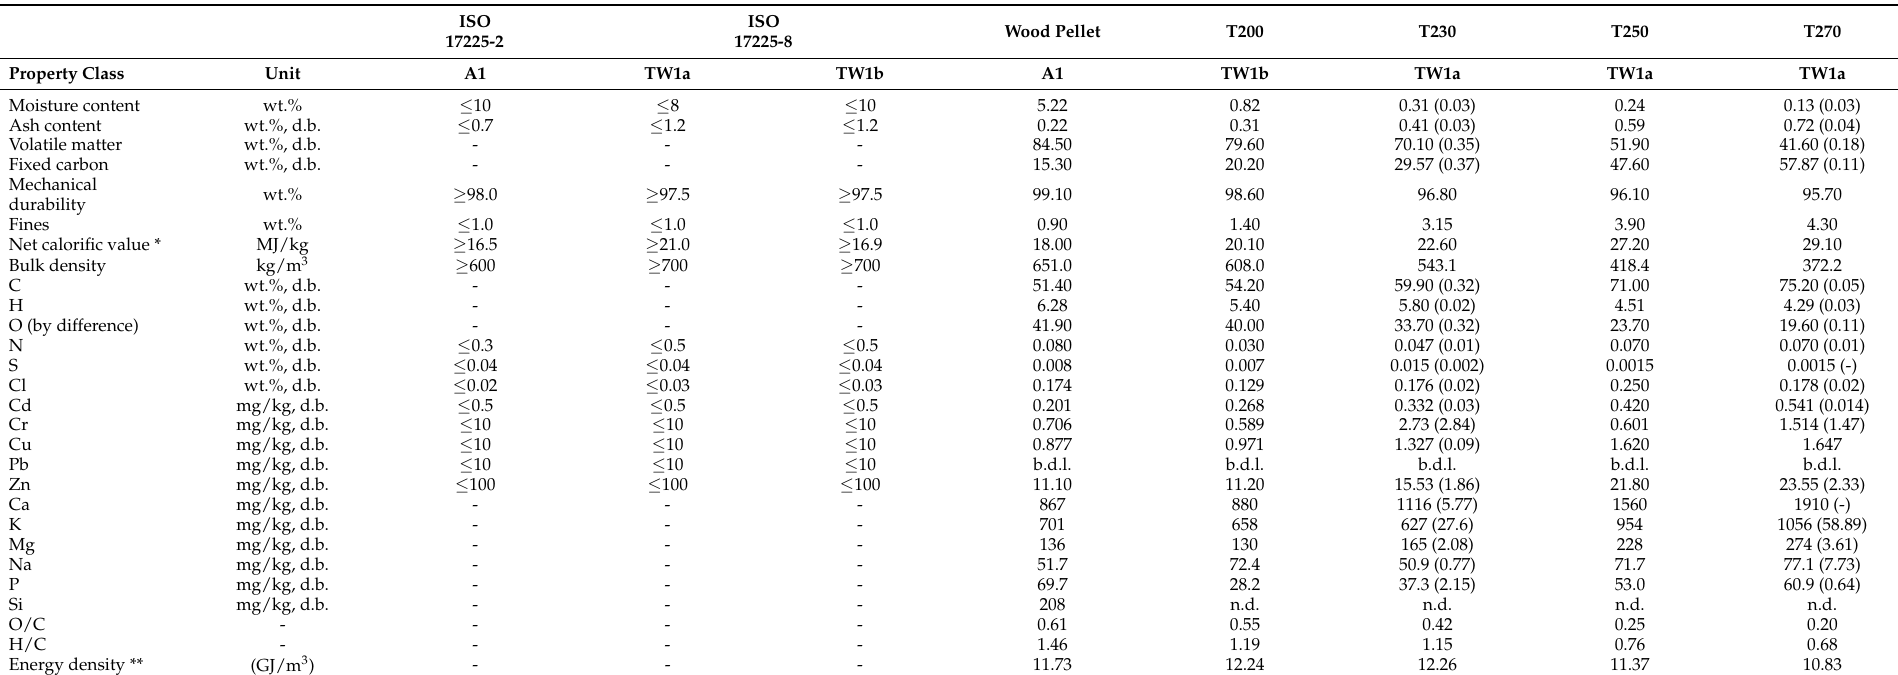
Table 6. The results of fuel analyses in comparison with the threshold values given in the product standard ISO 17225-2 for wood pellets and ISO/TS 17225-8 for torrefied biomass [24,41]. Numbers in parenthesis indicate the standard deviations for triple analyses. * as received ** Energy density was calculated based on using net calorific value and bulk density based on as received basis [41]. Abbreviations: A1: raw biomass pellet in ISO/TS-17225-2, TW1a: thermally treated and